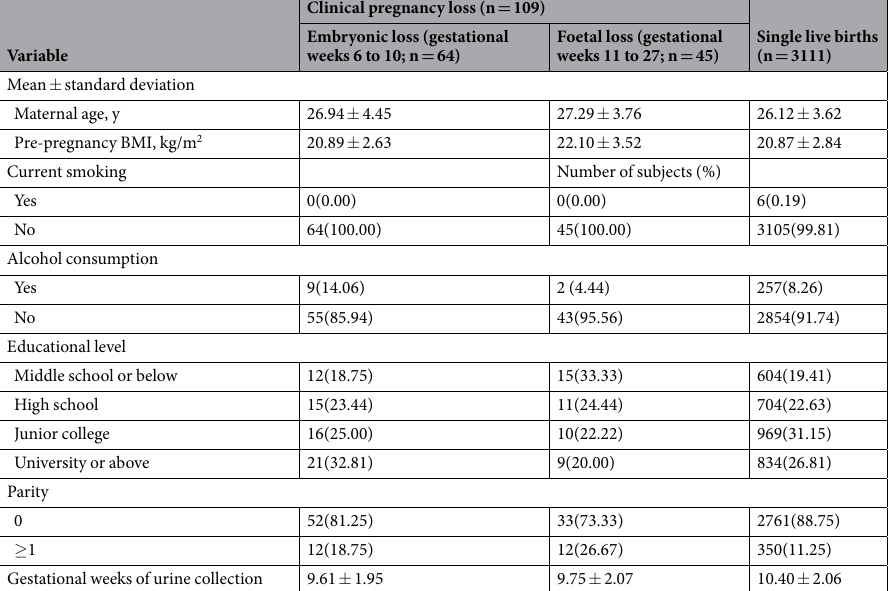
Table 1. Characteristics of participants enrolled in the present study (n = 3,220). Abbreviation: BMI, body mass index.